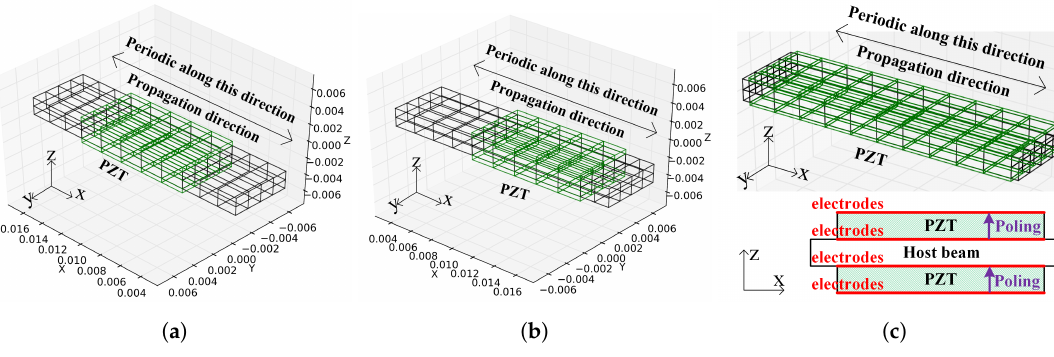
Figure 4. Unit cells of the piezoelectric waveguides: ( a ) unit cell A; ( b ) unit cell B which is a non-symmetric way of choosing the unit cell for the infinite periodic structure with unit cell A; ( c ) unit cell C which has longer PZT patches. The Piezoelectric materials are polarized along the z axis, and the electrodes fully cover the surfaces parallel to the x-y plane (orthogonal to the polarized direction). The program code used to generate the Finite Element models in ANSYS can be found in the Supplementary Files.